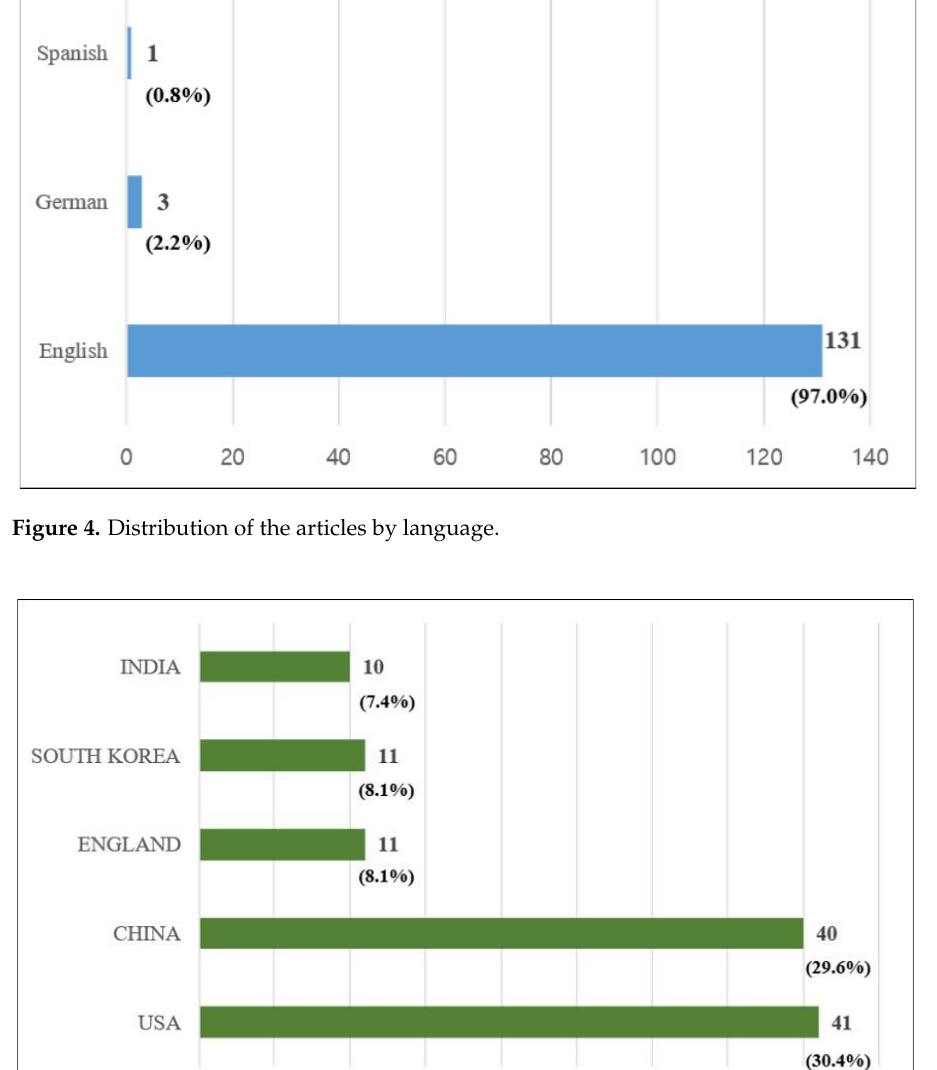
Figure 5. Top five countries of origin.